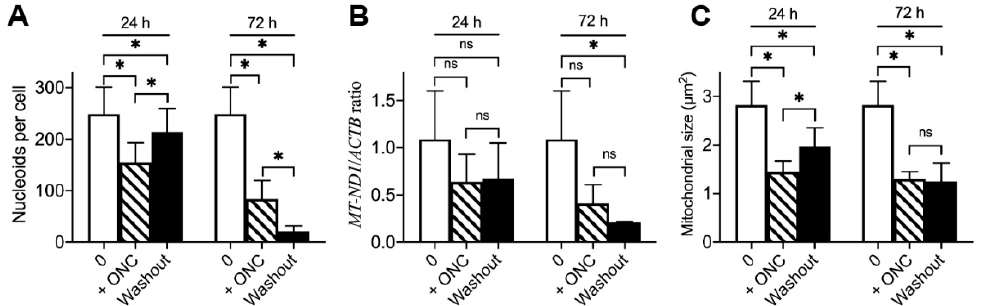
Figure 3. Long-lasting consequences of a single-dose treatment with ONC201 on the mitochondrial nucleoids, mtDNA, and mitochondrial morphology. ( A ), Average number of mitochondrial nucleoids per cell before, following single-dose 10 µ M ONC201 treatment (+ONC) and subsequent washout (washout); ( B ), Ratio of mtDNA gene MT-ND1 to nDNA encoded gene ACTB normalized to control (qPCR data); ( C ), Average size of mitochondria in 10 µ M ONC201 treated cells. Shown are the mean